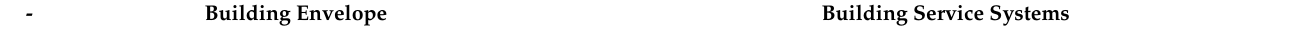
Table 2. Properties of cost-neutrally retrofitted apartment buildings (AB). Buildings from four time periods are presented: AB1 (–1975), AB2 (1976–2002), AB3